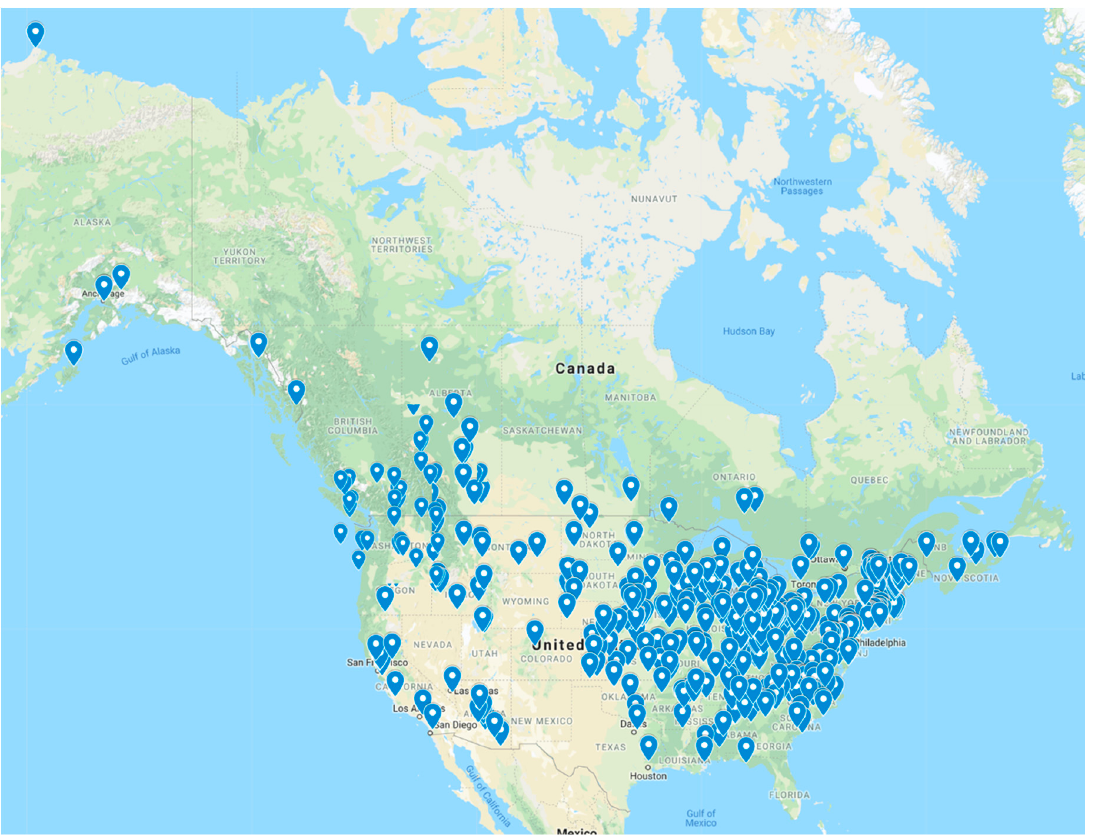
Figure 2. Map of public libraries in North America that indicated in an online survey that they have offered outdoor walking, hiking, bicycling, or running programs, n = 482.